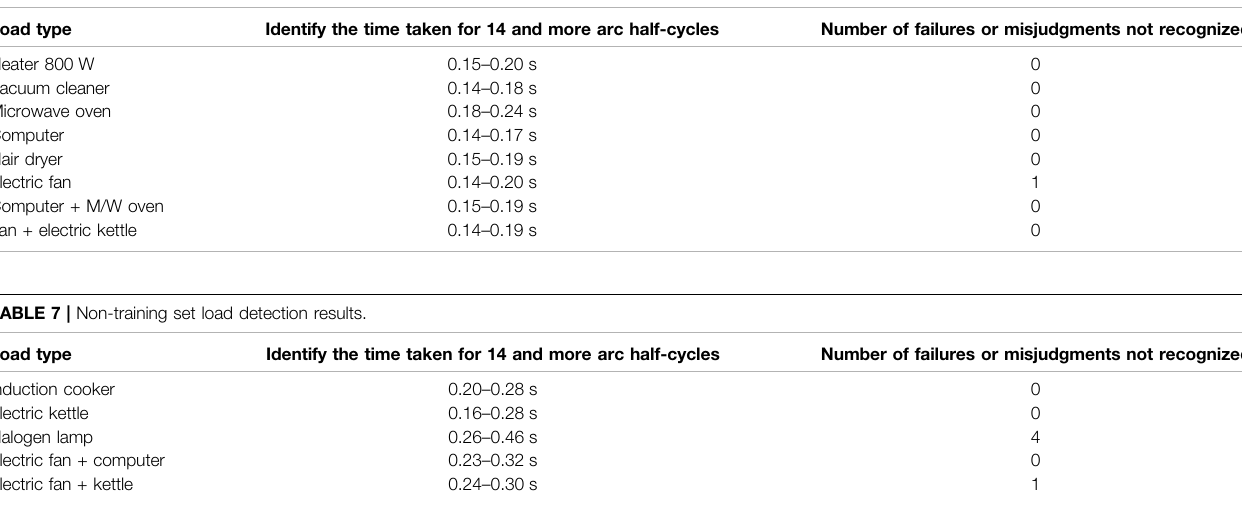
TABLE 6 | Statistics of arc fault detection results (GA-BP model).